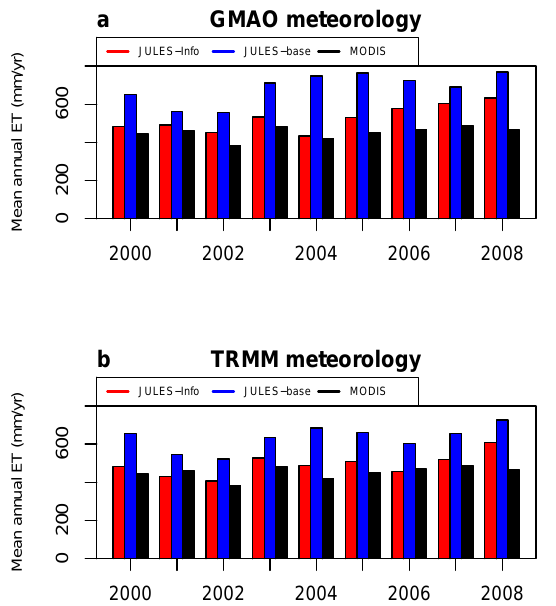
Figure 9. Comparison of the mean annual ET within our study area, as derived from JULES-base, JULES-Info and